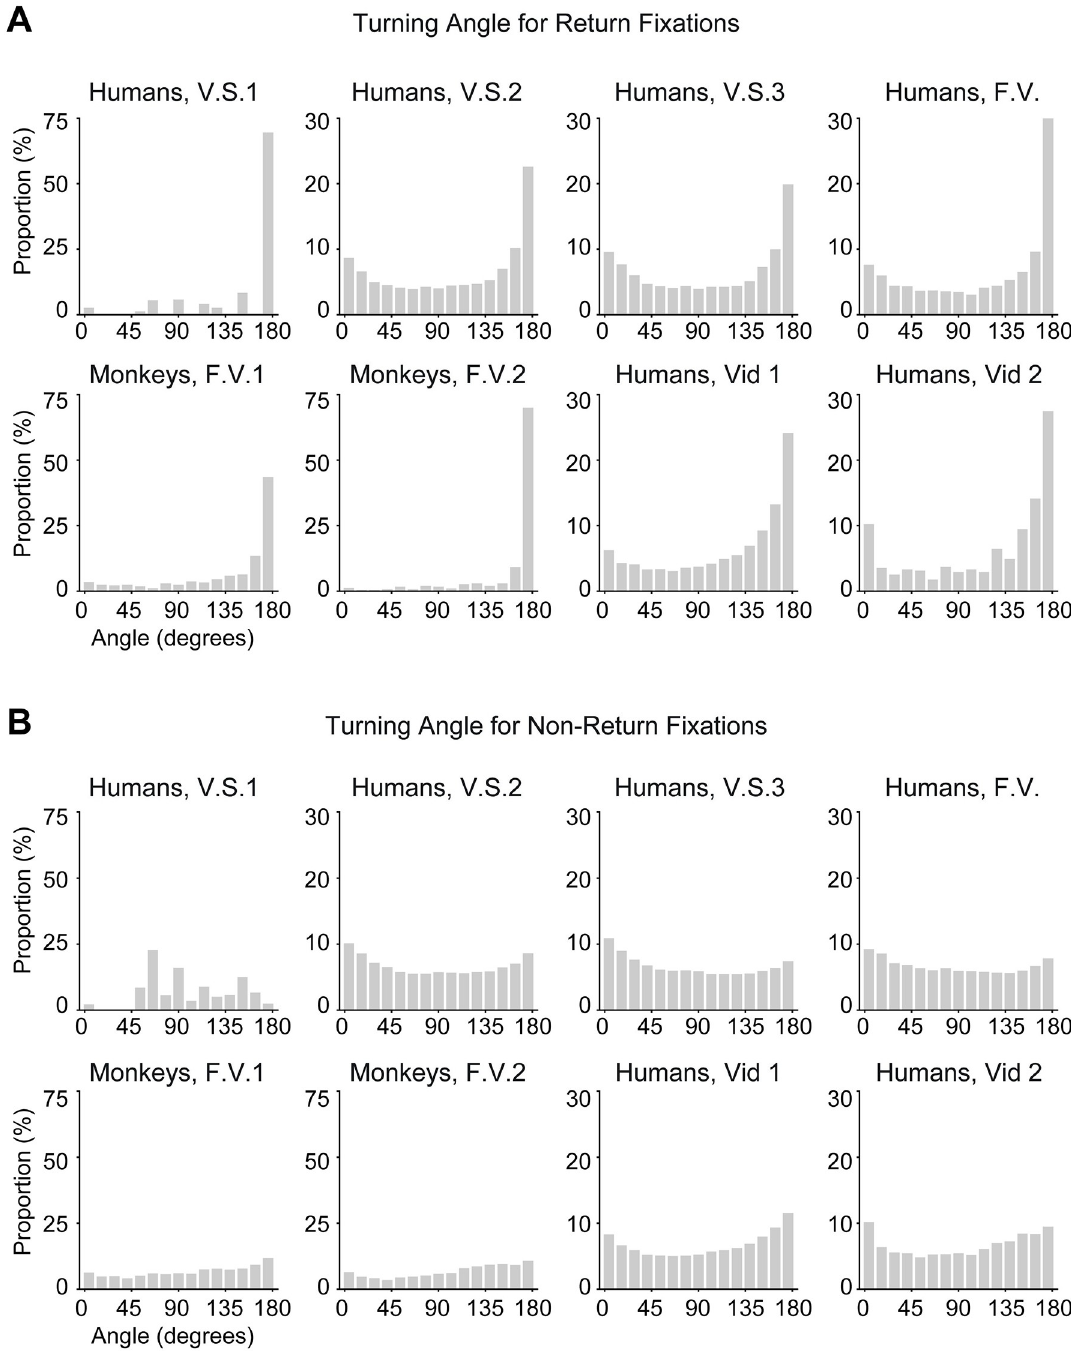
Fig 5. Subjects tend to make more saccades with turning angles of 180 degrees preceding return fixations. ( A ) Distribution of turning angles preceding return fixations. Bin size = 12 degrees. The sharp peak at 180 degrees shows that subjects often revert directions to return to their previously fixated location with short offsets (Fig 3). ( B ) Distribution of turning angles preceding non- return fixations. Bin size = 12 degrees. The curves tend to show a slight U-shape showing that subjects often either continue to move in the same direction or else move in the opposite